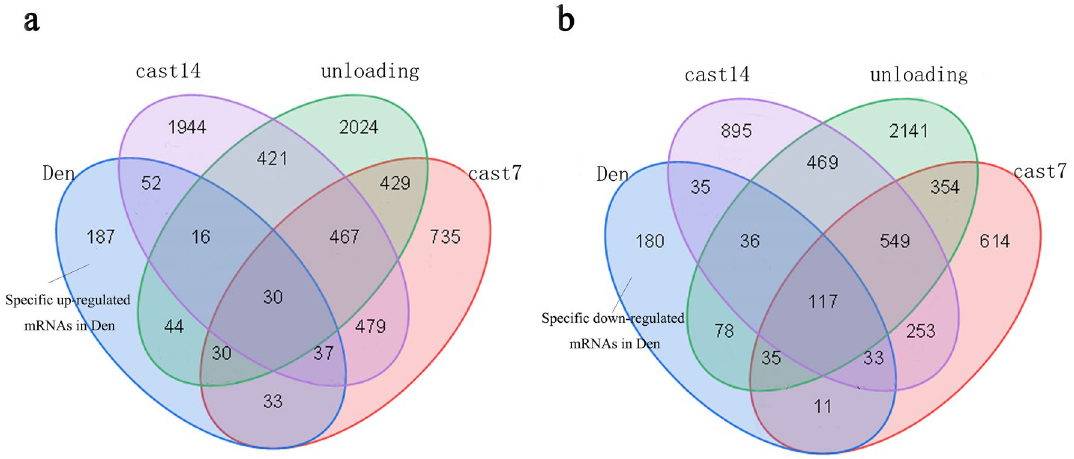
Figure 5. Specific mRNAs identified in denervated muscle atrophy. DEGs in denervated muscle atrophy retrieved by our meta-analysis (blue circle) were further compared with DEGs in disuse muscle atrophy caused by 7-day hindlimb casting (purple circle), 14-day hindlimb casting (red circle) and hindlimb unloading (green circle). ( a ) Venn for up-regulated genes. ( b ) Venn for down-regulated genes. Den denervation, cast 7 7-day hindlimb casting, cast 14 14-day hindlimb casting.